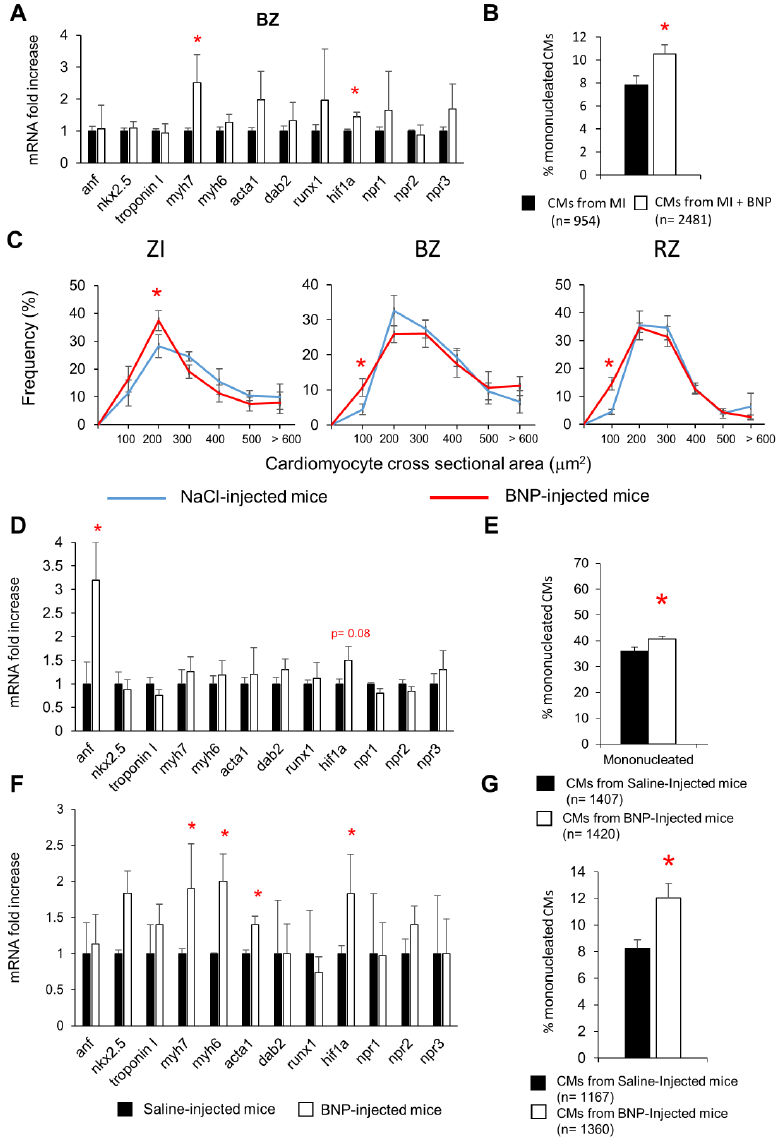
Figure 2. Cardiomyocytes share common characteristics in BNP-treated hearts. Cardiomyocytes were isolated from adult infarcted ( A – C ), unmanipulated neonatal ( D , E ) and adult ( F , G ) hearts treated with BNP (white) or saline (black). ( A , D , F ) Quantitative relative expression of mRNAs coding for different genes in CMs isolated from the BZ 10 days after surgery ( A , n = 9 and 6 different CM isolations from saline- and BNP-treated infarcted hearts, respectively), from unmanipulated neonatal ( D , n = 7 different CM isolations for both groups) and adult ( F , n = 8 and 7 different CM isolations from saline- and BNP-treated hearts, respectively) hearts. Results expressed as fold- increase above the levels in CMs isolated from saline-injected infarcted mice. anf: atrial natriuretic peptide; myh7: β Myosin heavy Chain; myh6: α Myosin heavy Chain; acta1: skeletal muscle α actin; hif1 α : hypoxic inducible factor 1 α ; npr1, 2 or 3: natriuretic peptide receptor A, B or C, respectively. ( B , E , G ) Percentages of mononucleated CMs. CMs isolated from 6 different saline- and BNP-treated hearts. The total number of CMs evaluated in brackets. ( C ) Cardiomyocyte cross- sectional area frequency in the ZI, BZ and RZ of the infarcted hearts, obtained after immunostainings with antibodies anti-laminin and anti-actinin of 6 different saline- and BNP-treated hearts. At least 50 CMs measured in the ZI, 100 in the BZ and 300 in the RZ for each heart on different pictures. All results represented as means ± SEM. * p <